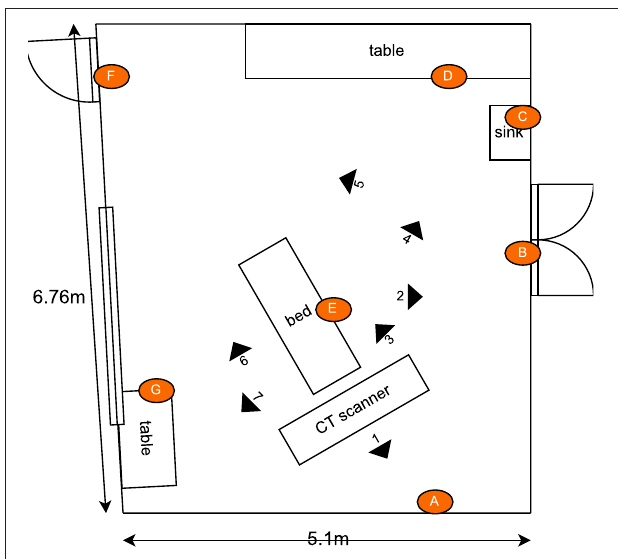
FIGURE 6 | Schematic illustrating the layout of the CT scan room used for the second hospital test. Indicated in the drawing are the locations of the swab points, and the approximate location of the robot during the defined irradiation periods. [Drawings not to exact scale].